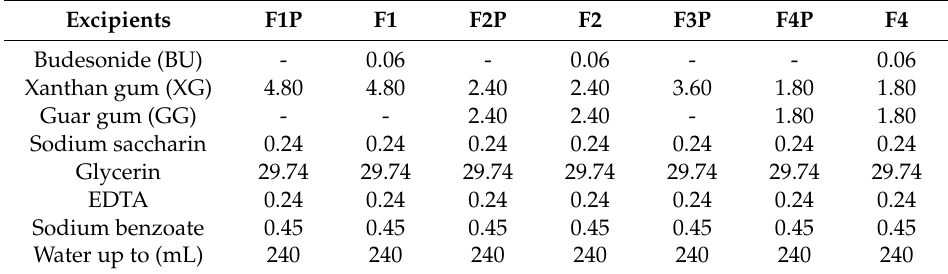
Table 1. Composition (expressed in grams) of the formulations for 240 mL (four doses each of 60 mL). Excipients